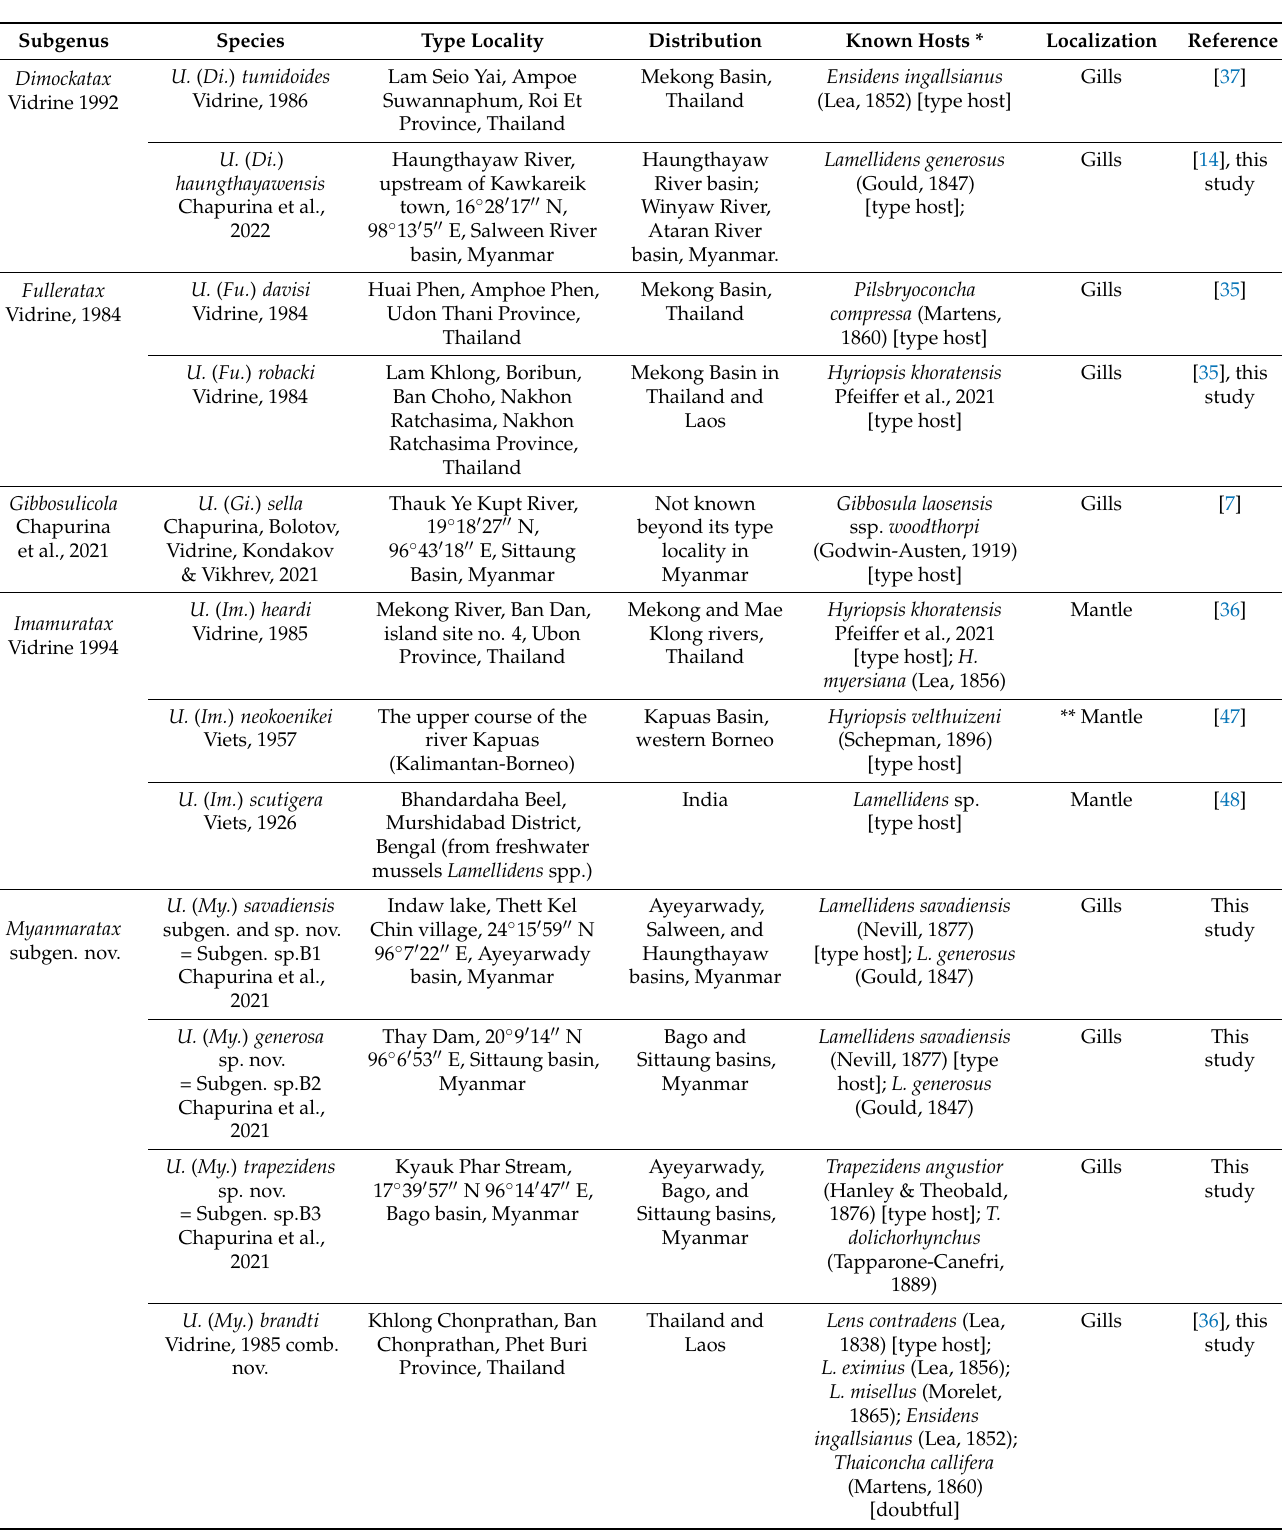
Table 1. Checklist of mussel-associated Unionicola mites (Unionicolidae) from Southeast Asia and India (without species that have been identified phylogenetically but have not been described yet, and free-living